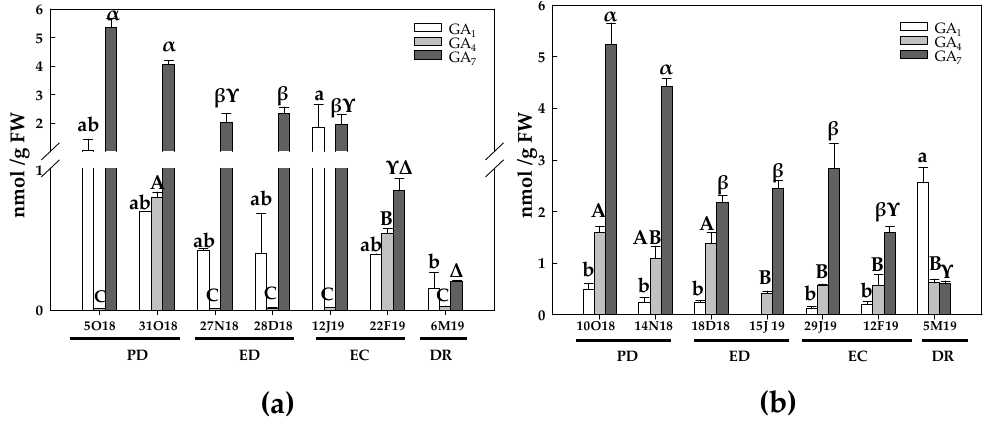
Figure 17. Evolution of gibberellins contents in flower buds of peach ‘GEM020’ cultivated in a cold area during the dormancy cycle on two seasons. ( a ): season 1 (2017–2018); ( b ): season 2 (2018–2019). Data represent the mean ± SE, n = 5. Different letters (lowercase, uppercase and Greek letters for GA 1 , GA 4 and GA 7 , respectively) indicate significant differences according to Tukey’s multiple test ( p ≤ 0.05). PD: paradormancy; ED: endodormancy; EC: ecodormancy; DR: dormancy release. FW: fresh weight. The chill units accumulated at the different times and locations are shown in Supplemental file 1.